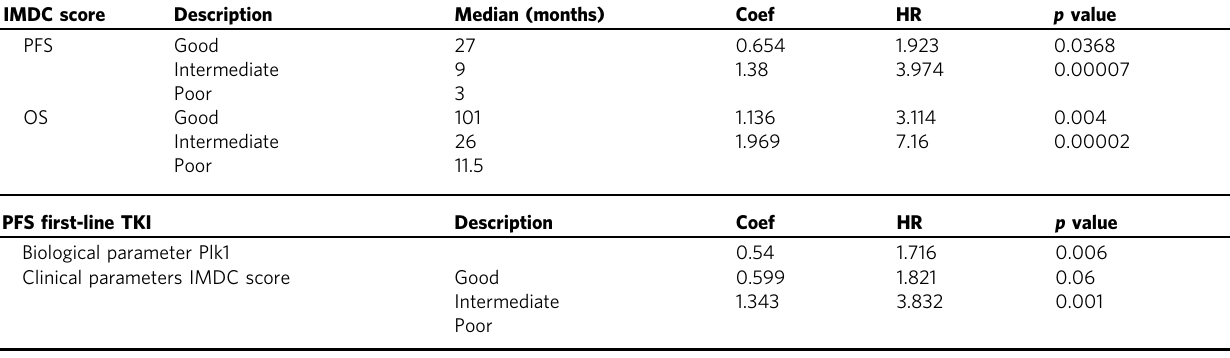
Table 4 Multivariate analysis — metastatic ccRCC